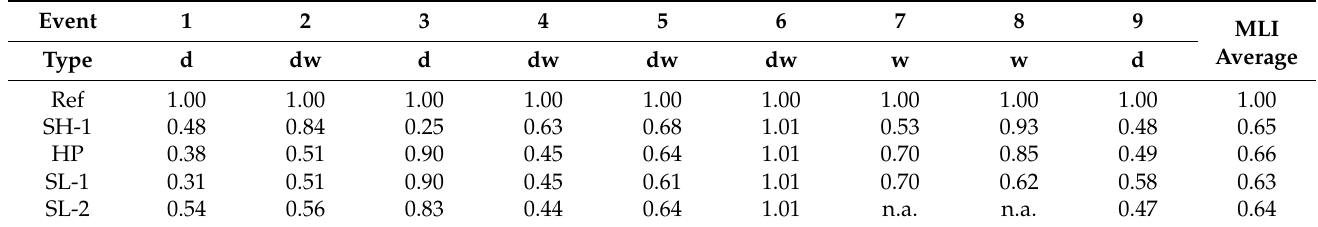
Table 6. MLI index for the tested samples during the snowfall events. n.a data are not